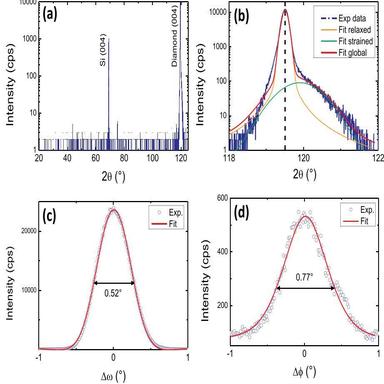
XRD characterization of epitaxial diamond layer grown on Ir/STO/Si(001): (a) large θ/2θ scan; (b) θ/2θ scan focused on the (004) reflection of diamond; (c) ω-scan around the (004) reflection of the diamond; (d) ϕ-scan around the (220) reflection of the diamond at the surface region in GIXRD.